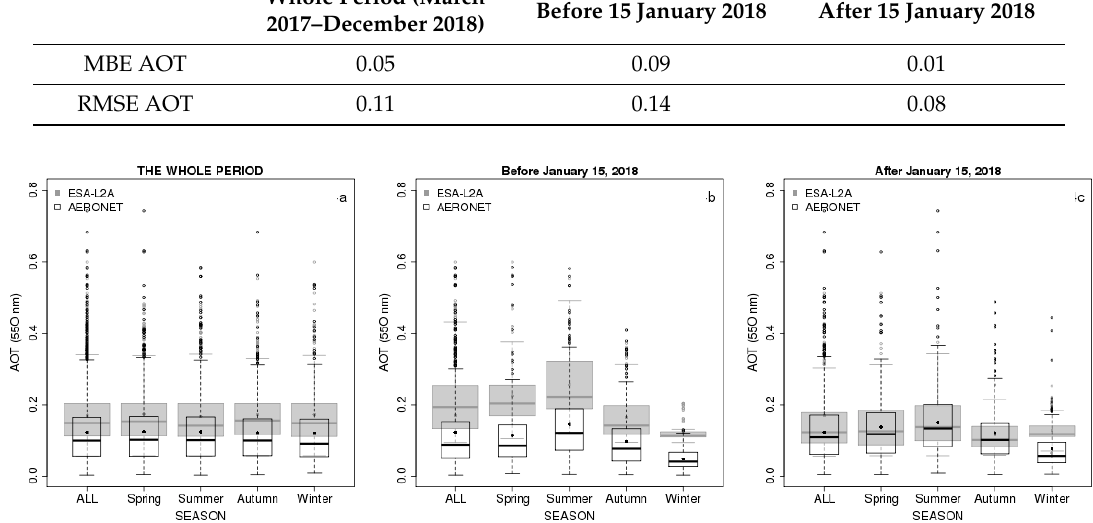
Figure 4. Box and whisker plots of AOT ESA-L2A and AERONET databases for the entire time period and for each season of that time period, considering the entire study period ( a ), the first sub-period ( b ) and the second sub-period ( c ). The mean (filled circles), median (horizontal segment within the box), 25 th and 75 th percentiles (top / bottom box limits) and the data within 1.5 times the interquartile range (whiskers) are shown.